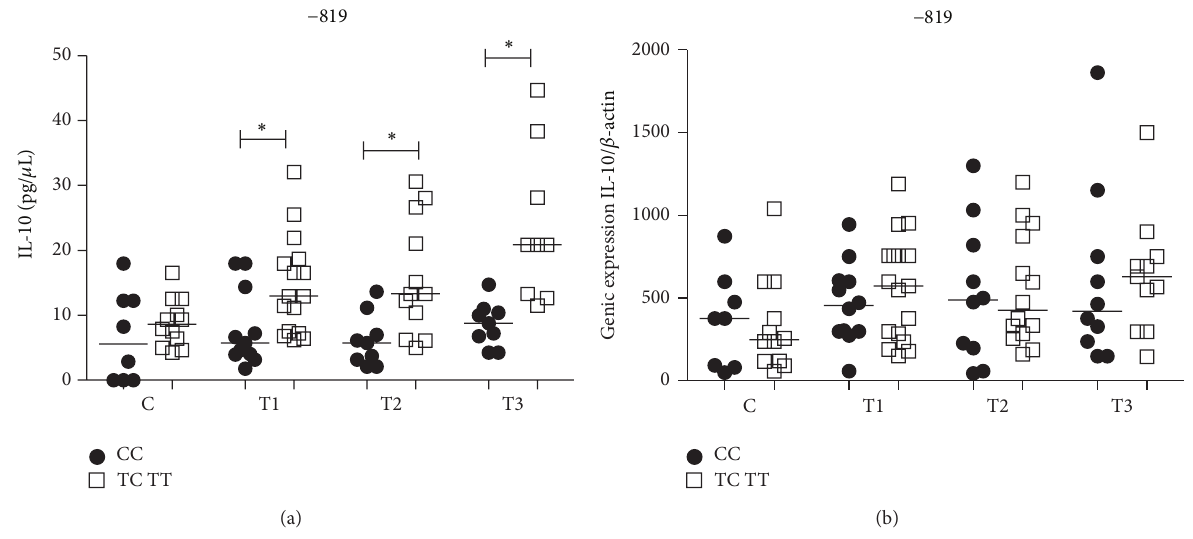
Figure 6: Influence of IL10 − 819C/T gene SNP on IL-10 plasma levels (a) and mRNA expression (b) in the control group (C) and PTB patients group at three time points of the treatment: T1 (after diagnosis and first month), T2 (three months), and T3 (six months). Data are shown as median levels ∗ 𝑃 < 0.05 .